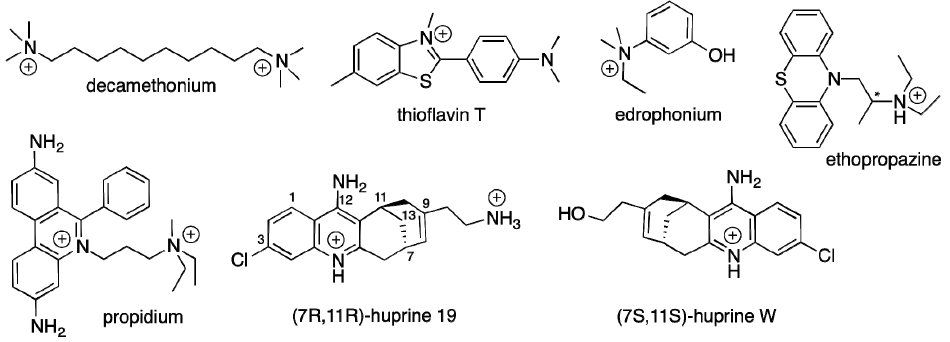
Figure 2. Chemical structures of the compounds used in this study. * denotes a chiral